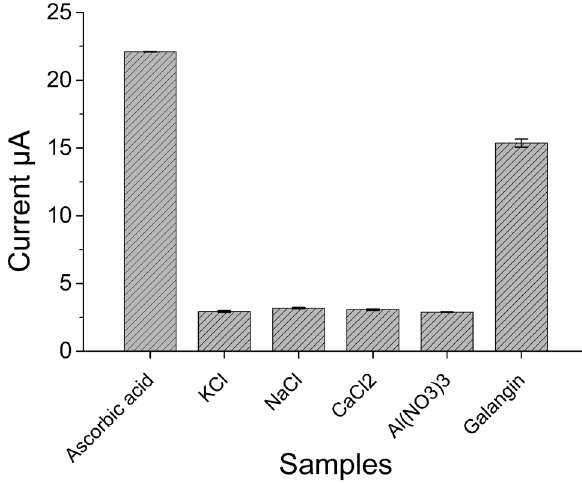
Figure 5: The selectivity of G/PTH/NG/GCE in the detection of samples ( KCl, NaCl, CaCl 2 , Al ( NO 3 ) 3 and galangin: 5.0 μ mol L − 1 )